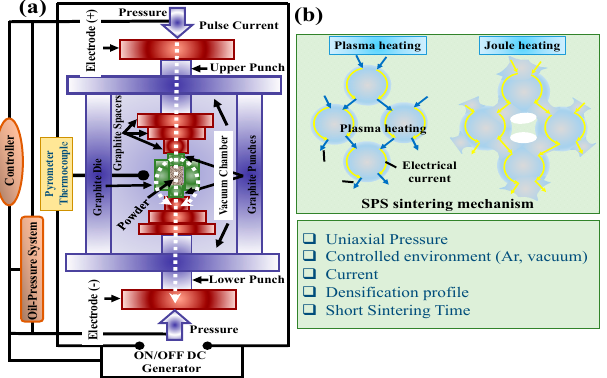
Figure 1. ( a ) Schematic representation of the spark plasma sintering (SPS) equipment and ( b ) SPS mechanism .